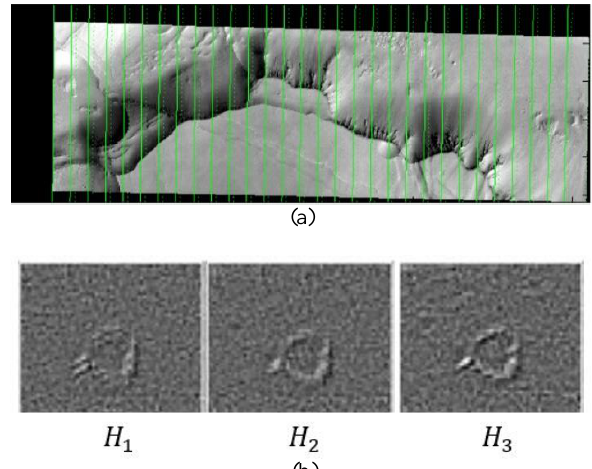
Figure 4 In (a) mosaicking from CaSSIS first stereo framelets. In (b) the Laplacian filter applied to an overlapping zone mosaicked for consecutive repetitions of the procedure described, the best alignment is reached at third